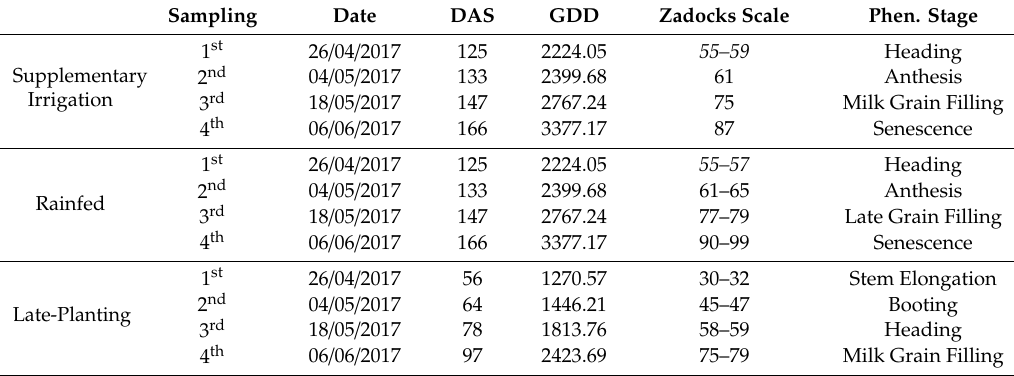
Table 1. Phenology information of the crop across the measuring / sampling visits, presented as days after sowing (DAS), the growing degree days (GDD), and the developmental period of the crops, expressed with the Zadocks growth scale and the phenological stage.